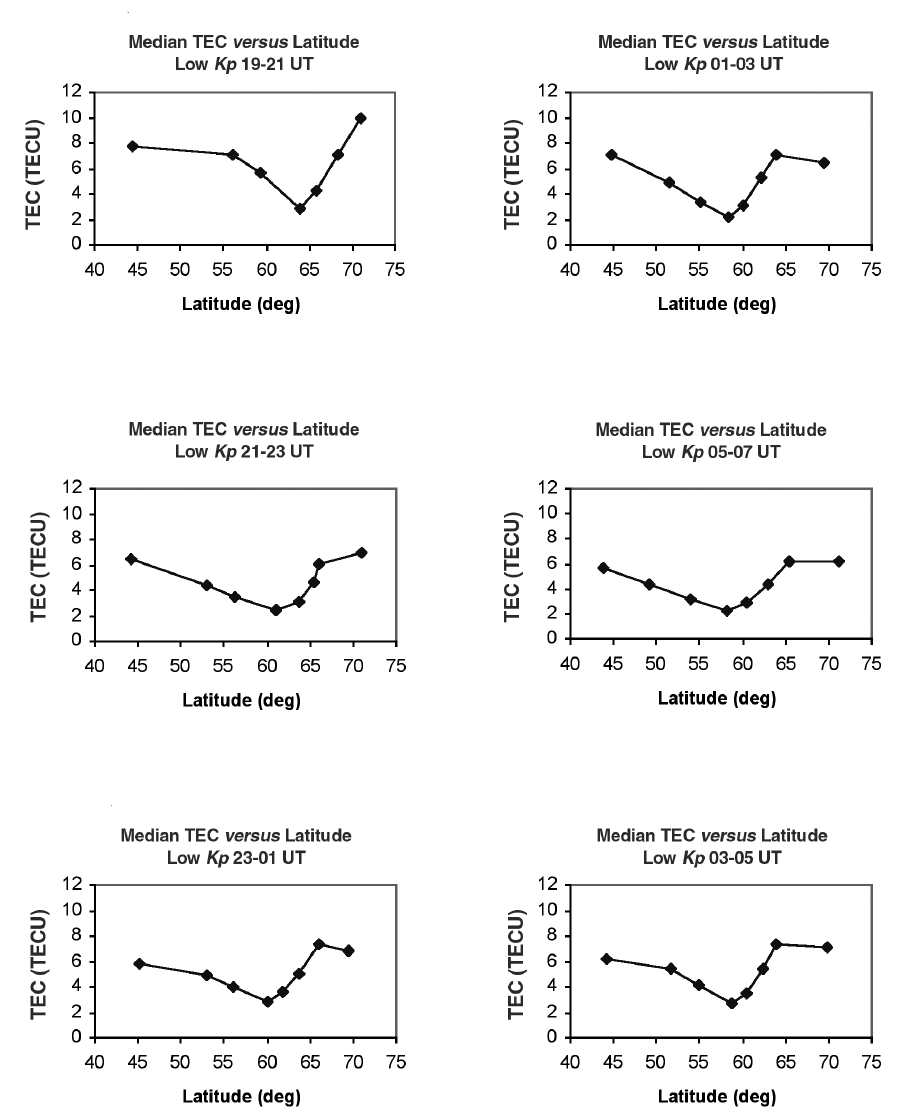
Fig. 8.8a. Median TEC versus latitude profiles of trough shape for successive two-hour bands throughout the night under quiet geomagnetic